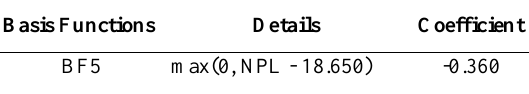
Table 9: Basis Functions of NPL